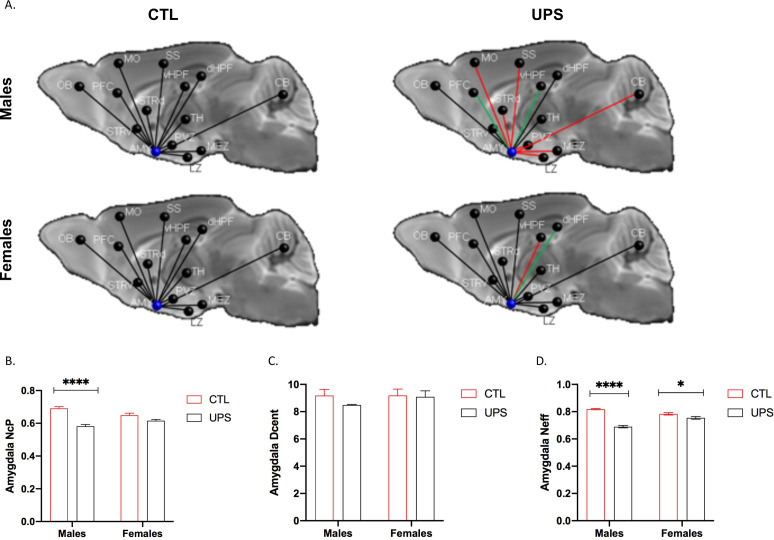
AMY regional connectivity using an expanded cohort of animals (n = 12–13 per rearing and sex, total n = 49 mice).(A) Schematic representation of AMY connectivity with other brain regions. Red lines indicate reduced connectivity and green lines indicate enhanced connectivity compared to same sex group. (B) Nodal centrality (NcP) showed significant rearing (F (1, 45)=42.56, p<0.0001) and interaction (F (1, 45)=12.23, p=0.0011), but no significant effect of sex (F (1, 45)=0.15, p=0.70). Sidak’s post-hoc analysis showing significant increase in nodal centrality in males (p<0.0001) but not in females (p=0.078). (C) Degree of centrality (Dcent) revealed no significant effects of rearing, sex, or interaction. (D) Nodal efficiency showed significant rearing (F (1, 45)=89.41, p<0.0001) and interaction (F (1, 45)=35.40, p<0.0001), but no significant effect of sex (F (1, 45)=3.39, p=0.072). Sidak’s post-hoc analysis found significant increase in nodal centrality in males (p<0.0001) and in females (p=0.036). Abbreviations: amygdala (AMY), cerebellum (CB), dorsal hippocampus (dHP), dorsal striatum (STRd), lateral hypothalamic zone (LZ), medial hypothalamic zone (MEZ), motor (MO), olfactory bulb (OB), periventricular zone (PVZ), prefrontal cortex (PFC), somatosensory cortex (SS), thalamus (TH), ventral hippocampus (vHP), ventral striatum (STRv). Mean and SEM, *p<0.05, ****p<0.0001. Figure 11—source data 1.